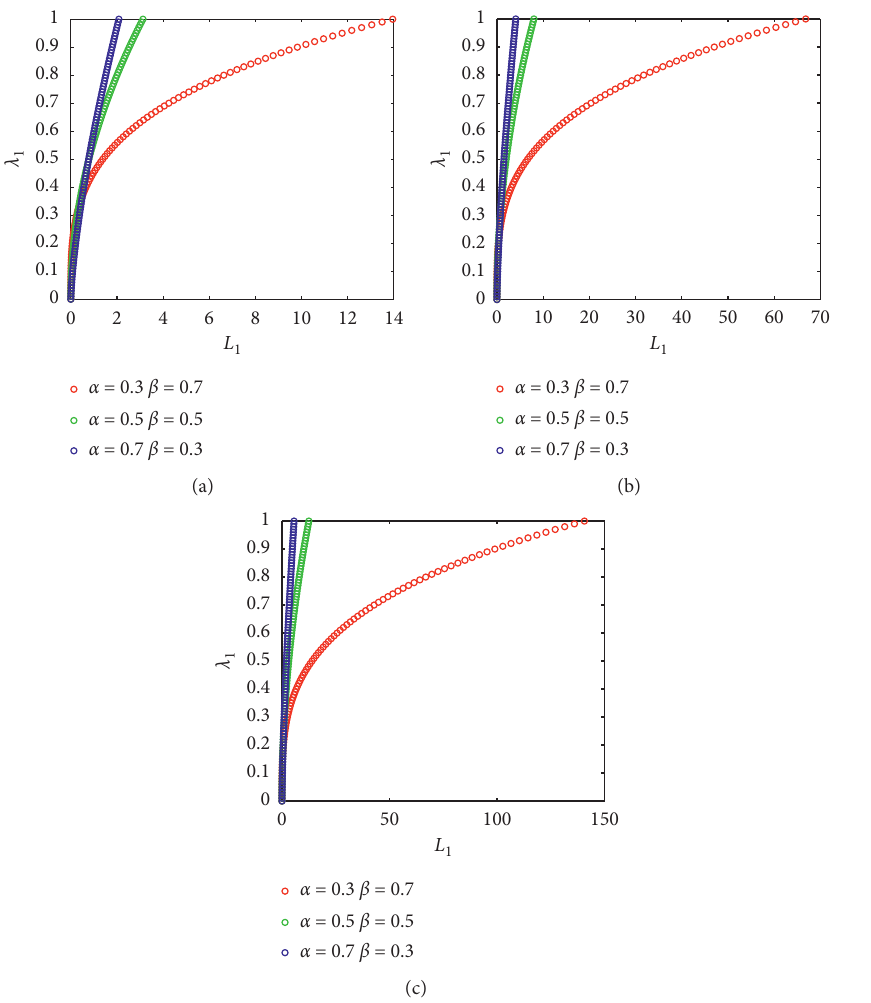
Figure 1: The influence mechanism of labor input level on the income distribution coefficient of pension institutions. (a) A � 5 , a A � 8 , a � 2. (c) A � 10 ,a � 1 1